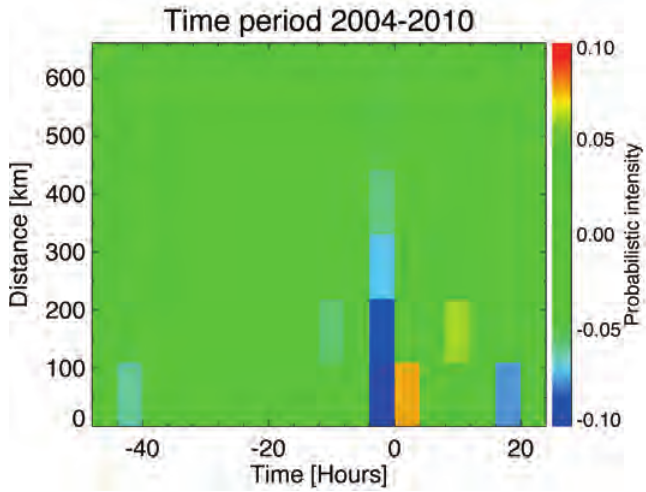
Figure 4. Distance-time dependence of the probabilistic intensity (without normalization; see text) obtained for the night-time electric field data measured at a frequency of about 1.7 kHz close to earthquakes with magnitude ≥ 5.0 and depth ≤ 40 km.